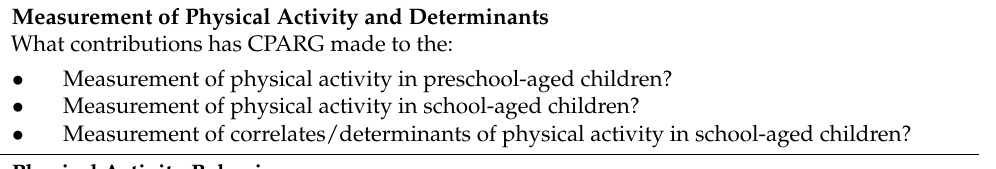
Table 2. Guiding Questions for Critical Review of Selected CPARG